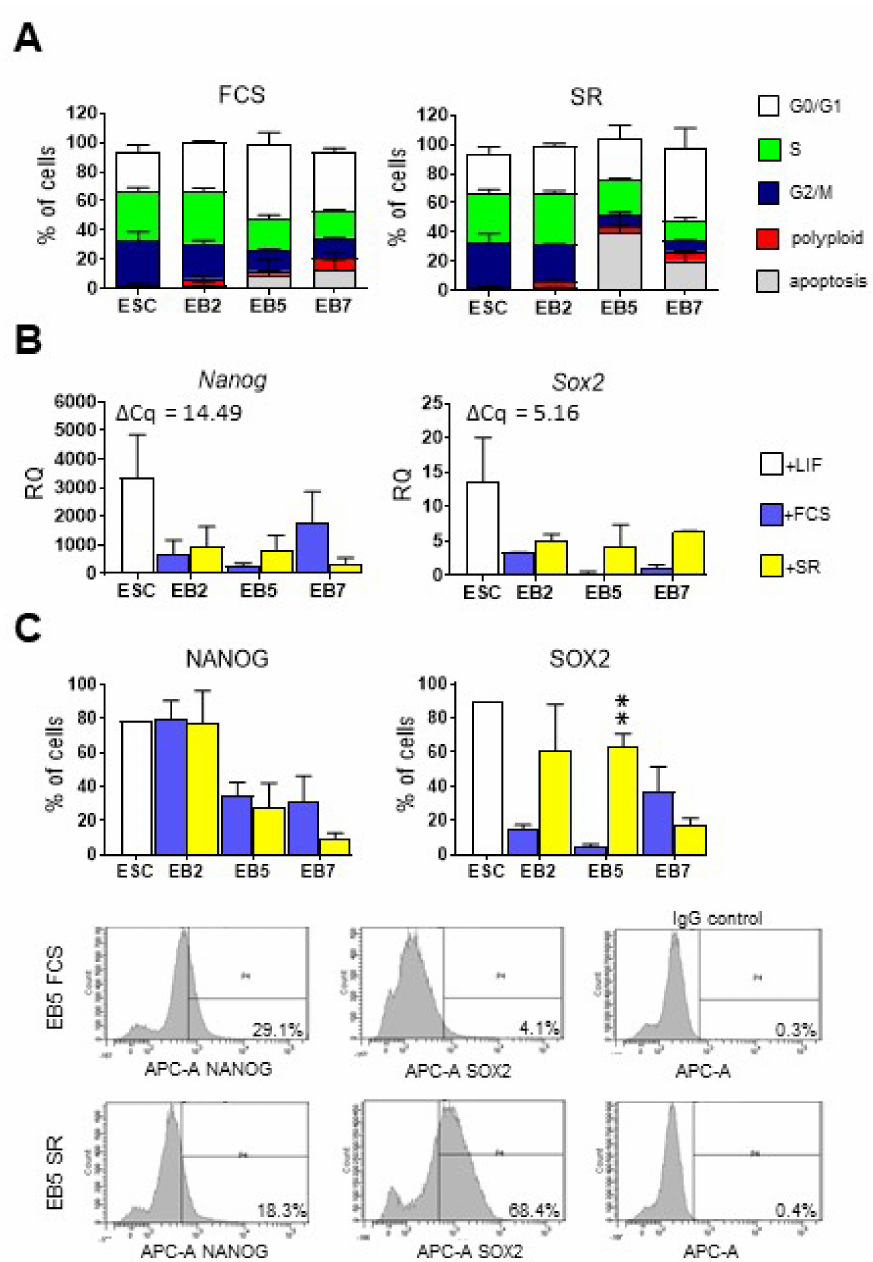
Figure 1. Analysis of cell cycle and pluripotency marker expression in undifferentiated ESCs and EBs cultured in medium supplemented either with FCS or SR. ( A ) The proportion of cells in different stages of cell cycle analyzed by propidium iodide staining. On the graph, the proportion of cells during each cell cycle phase is presented: G0/G1, S, G2/M as well as apoptotic and polyploid cells. ( B ) Expression of pluripotency markers: Nanog and Sox2 . β -actin was used as a reference gene. RQ = 1 for the level of gene expression detected in a 13.5-day-old mouse embryo (reference sample). The average ∆ Cq for reference sample is shown on each graph. Data presented as means of three independent experiments with standard deviations. ( C ) The proportion of undifferentiated ESCs and cells obtained after disaggregation of EB2, EB5, and EB7 synthesizing NANOG or SOX2, analyzed with flow cytometry. Data presented as means of three independent experiments with standard deviations; ** p < 0.01. Representative histograms present proportion of EB5-derived cells synthesizing NANOG or SOX2, and cells incubated with IgG only (negative